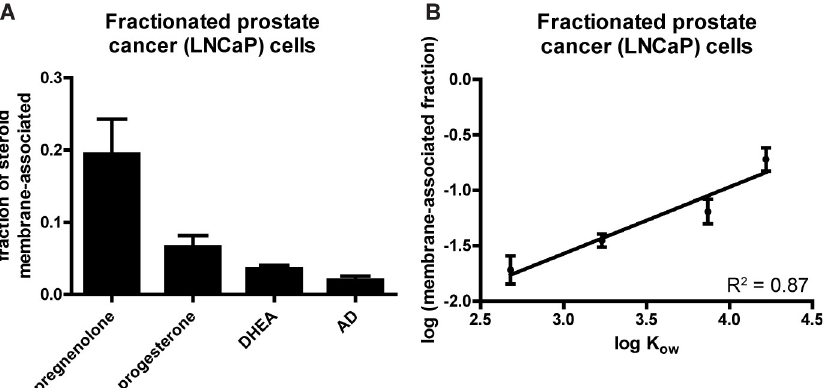
Fig 8. More lipophilic steroids preferentially accumulate in membrane fractions of cells. (A) Fraction of the total steroid content in the membrane plus cytosol fractions that was contained in the membrane fraction for four different steroids after fractionation of LNCaP cells that were treated with 1 μ M unlabeled steroid. Graphs show mean ± SD from two independent experiments each performed in triplicate for each steroid. Pregnenolone content in membrane fractions was greater than any other steroid (Tukey’s multiple comparison test after one-way ANOVA, p < 0.001 for all three comparisons). (B) Graph of logs of the data from (A) vs. log K ow of the four steroids. Slope of trendline is different from zero (p <